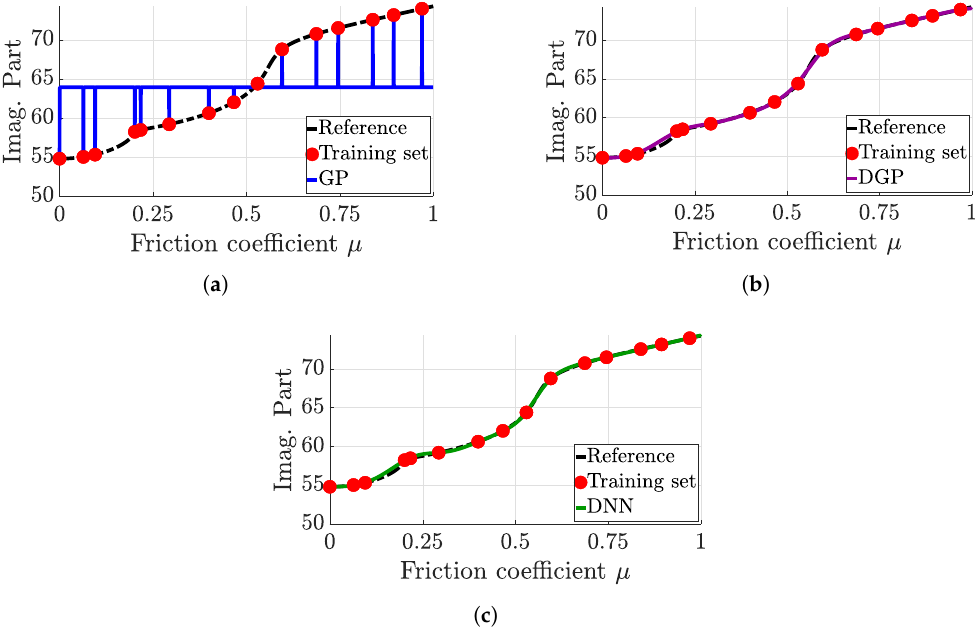
Figure 10. Comparison of each surrogate model prediction for a faulty GP setting. ( a ) Gaussian process ( 15 samples ), ( b ) deep Gaussian process ( 15 samples ), ( c ) deep neural network ( 15 samples